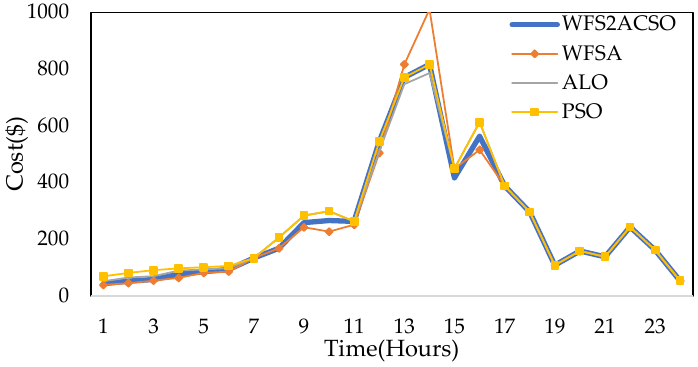
Figure 27. Cost comparison of various techniques for commercial area.